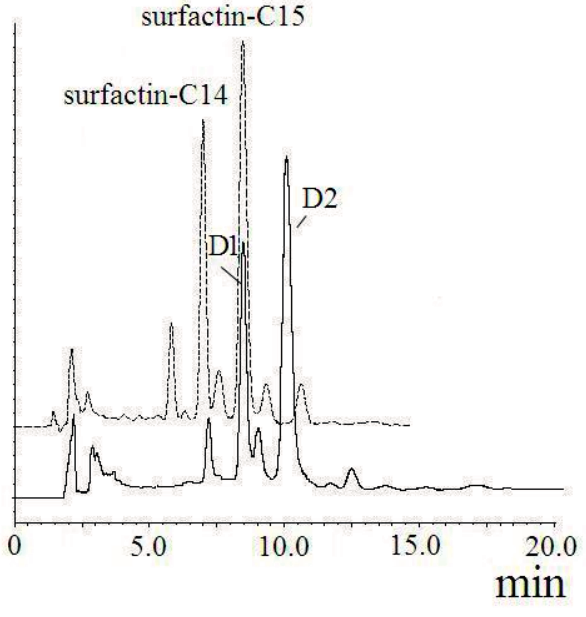
Figure 10. HPLC spectra of surfactin (dashed line) and (Glu- γ , Asp- β )-6-hydoxyl-hexyl- surfactin ester (solid